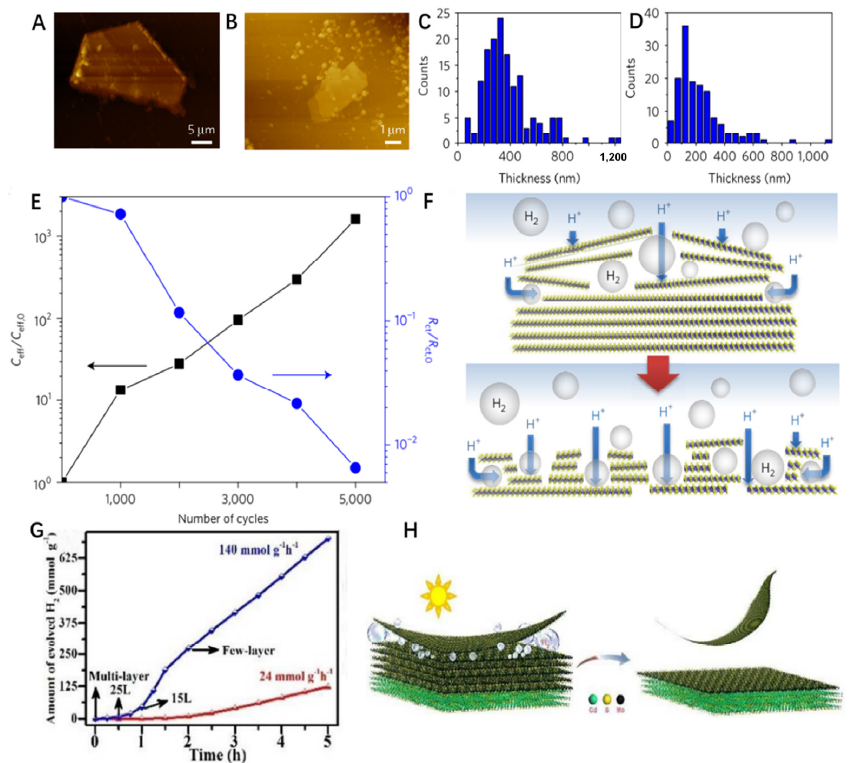
Figure 3. AFM images of H-TaS 2 before ( A ) and after ( B ) the reaction. ( C , D ) Statistical thickness distributions of H-TaS 2 before and after the reaction, respectively. ( E ) Variations of effective capac- itance (C eff /C eff,0 , where 0 is the initial value) and charge transfer resistance (R ct /R ct,0 ) with cycling. ( F ) Schematic diagram of the mechanism of the morphological evolution process. The flat plate represents the MX 2 layer, and the sphere represents the H 2 bubble generated during the HER. Repro- duced with permission from [30], ©Springer Nature 2017. ( G ) Photocatalytic hydrogen production performance of vdWHs under high (red line) and low (blue line) pressure conditions. ( H ) Schematic diagram of the process principle based on bubble exfoliation to prepare highly active MoS 2 /CdS vdWHs. Reproduced with permission from [31], ©The Royal Society of Chemistry